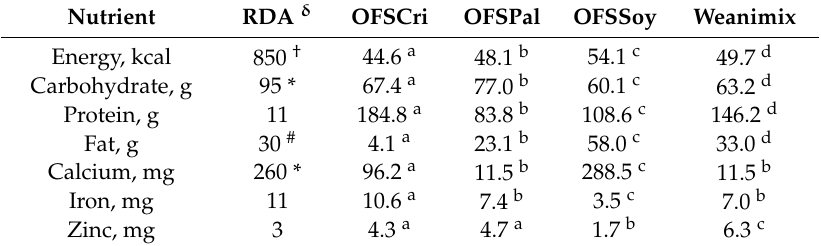
Table 3. Contribution (%) of energy, carbohydrate, protein, fat, Ca, Fe and Zn content of porridge from 100 g of OFSP-based CFs and Weanimx meeting RDA for children aged 6–12 months 1 . Nutrient RDA δ OFSCri OFSPal OFSSoy Weanimix Energy, kcal 850 †